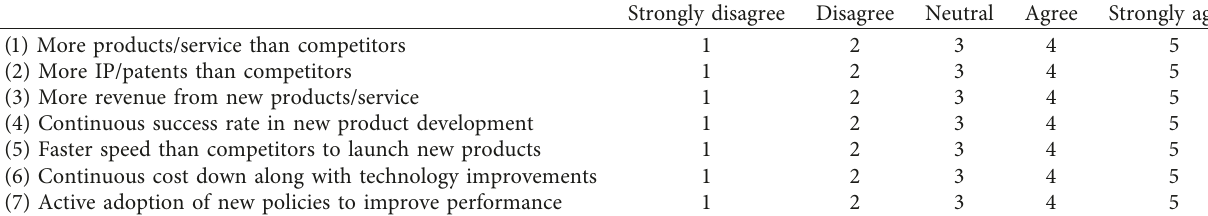
Table 11: Questions for dynamic